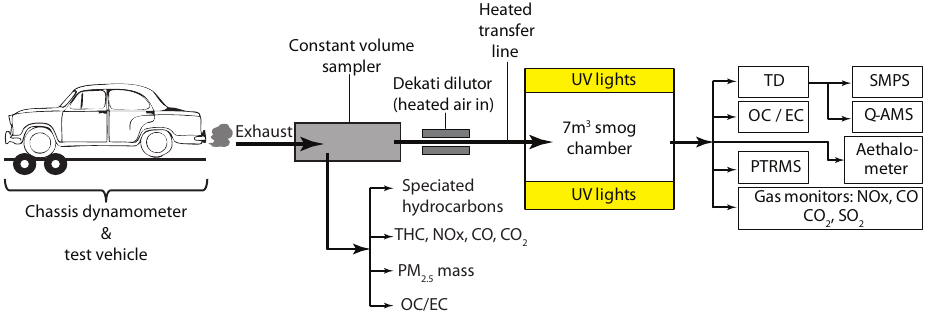
Fig. 1. Experimental setup used to characterize the primary and secondary particulate matter and gas-phase products from motor vehicle emissions. Not to scale. TD=thermodenuder; SMPS=scanning mobility particle sizer; Q-AMS=quadrupole aerosol mass spectrometer; PTRMS=proton transfer reaction mass